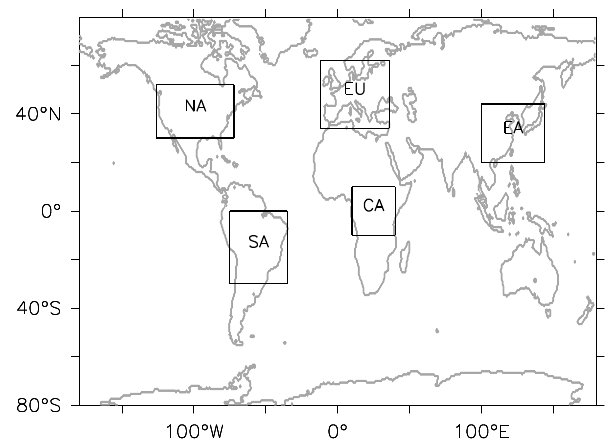
Fig. 13. Location and extension of the geographical regions used in the budget calculation. The regions are: North America (NA), Eu- rope (EU), East Asia (EA), Central Africa (CA) and South America